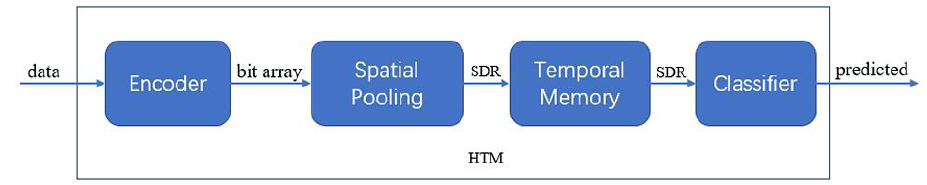
Figure 2. The learning process of the HTM.